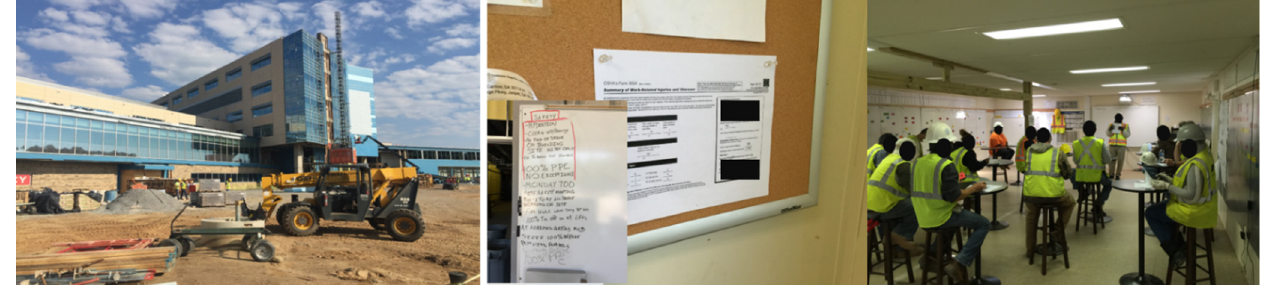
Figure 3. Construction workplace environment for survey questionnaire data collection (taken by Authors—Dr. Sungjin Kim and Dr. Javier Irizarry).